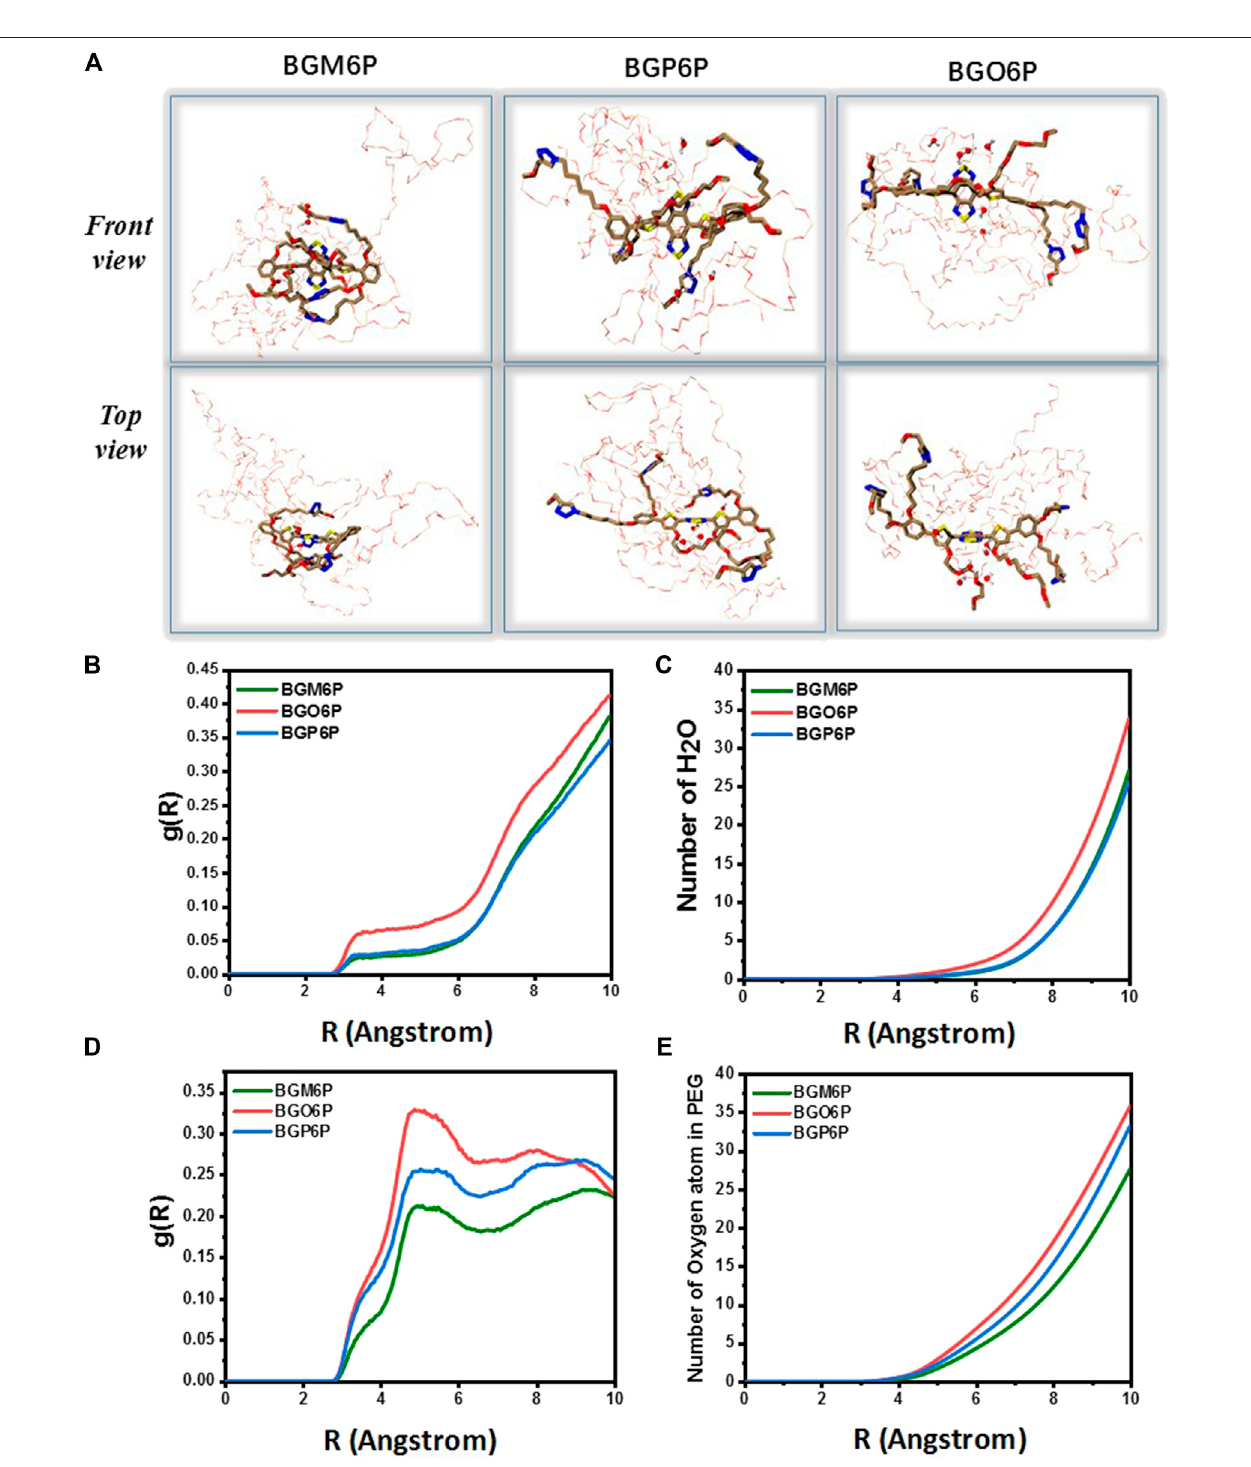
FIGURE 3 | (A) The front view (up) and top view (below) of fl uorophores in aqueous environment from molecular dynamics (MD) simulations. PEG chain: the bray and red thin part; carbon atom: brown; oxygen atom: red; sulfur atom: yellow; nitrogen: blue. (B) Radial distribution function (RDF) of oxygen atoms in water molecules and (C) counted the number of water molecules around the BBTD unit of fl uorophores. (D) Radial distribution function (RDF) of oxygen atoms in PEG chains and (E) counted umber of oxygen atoms in PEG chains around the BBTD unit of fl uorophores, where g(R) represents RDF (left) , R(Å) means the radius in angstrom.